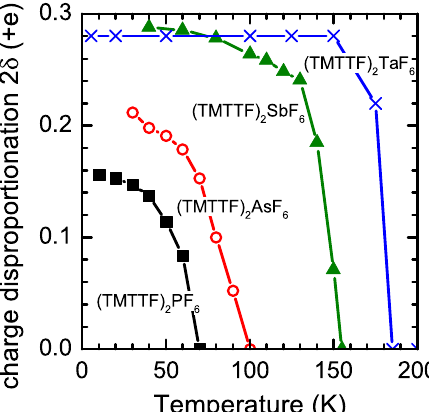
Figure 2. Temperature dependence of the charge dispropotionation probed by the splitting of the infrared-active ν 28 molecular vibrational mode in (TMTTF) 2 X with X = PF − a function of temperature T recorded along the c axis. The charge imbalance 2 δ is estimated from the difference of the two resonance frequencies by 2 δ = ∆ ν / ( 80 cm − 1 / e )